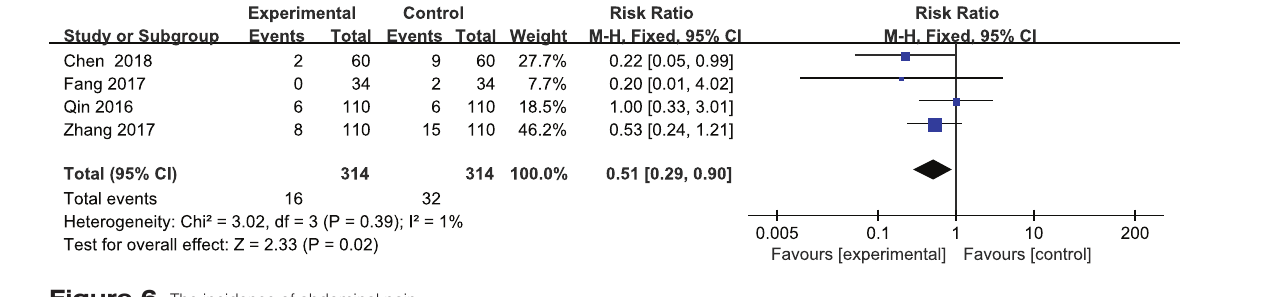
Figure 6. The incidence of abdominal